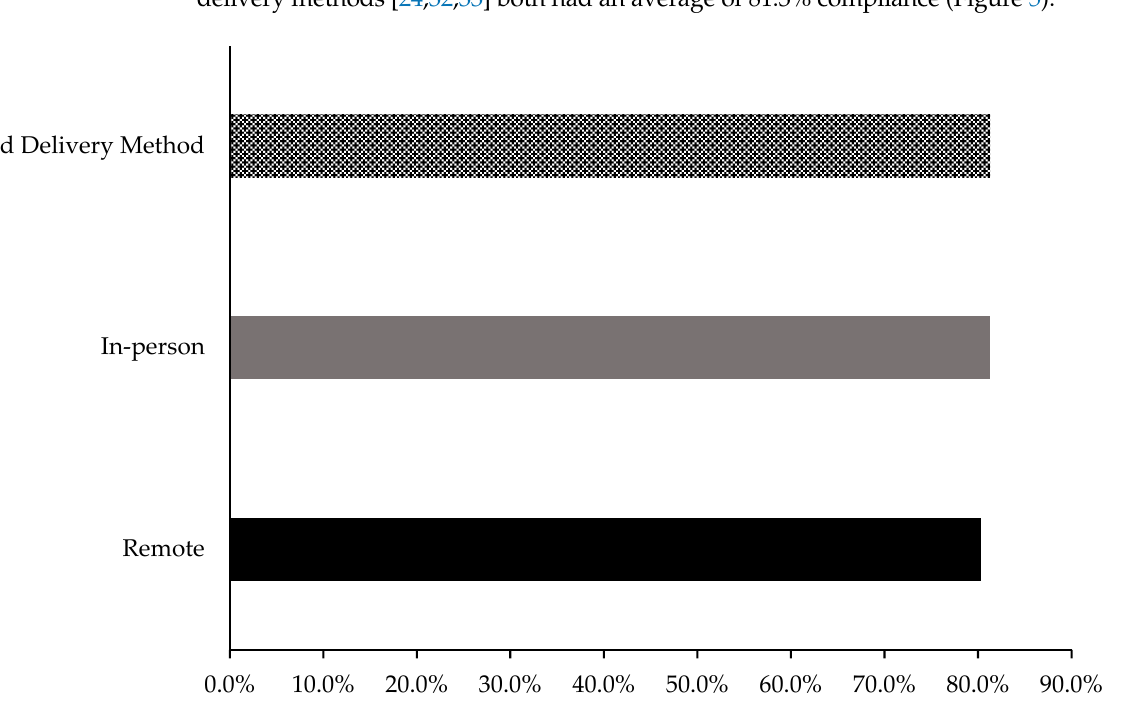
Figure 5. Participant compliance to the exercise intervention in remote, in-person and mixed deliv- ery studies.